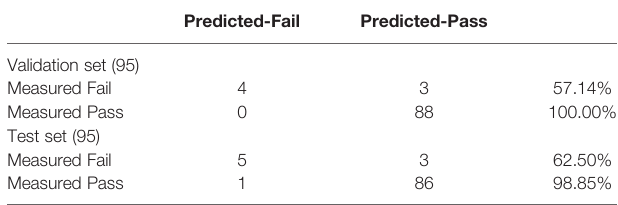
TABLE 1 | Results of classi fi cation model.